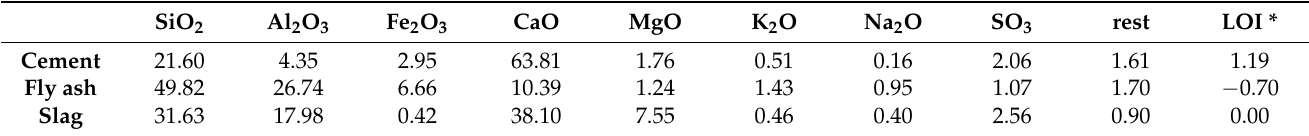
Table 1. Chemical composition of PII 42.5 Portland cement